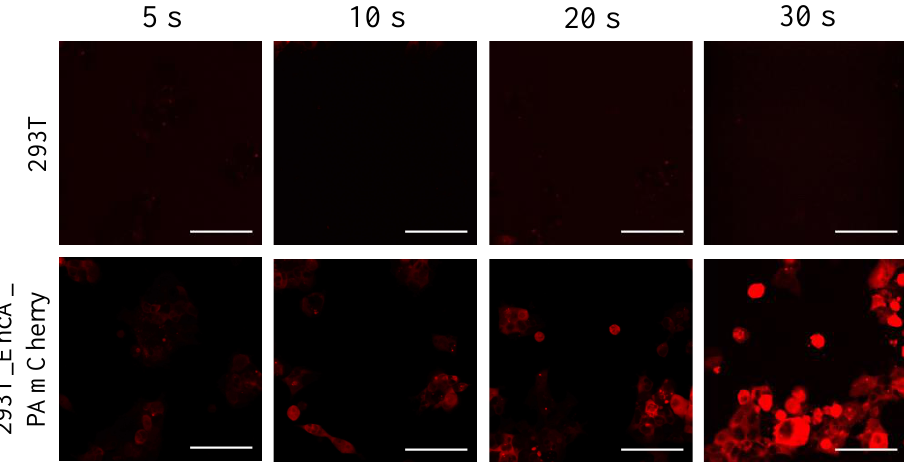
Figure 2. 293T ( upper panel ) and 293T EncA_PAmCherry ( lower panel ) cells were imaged after irradiation with 405 nm laser for 5 s, 10 s, 20 s and 30 s followed by 561 nm excitation. Laser scanning confocal microscopy, Nikon Eclipse Ti2, scale bars are 50 μm.